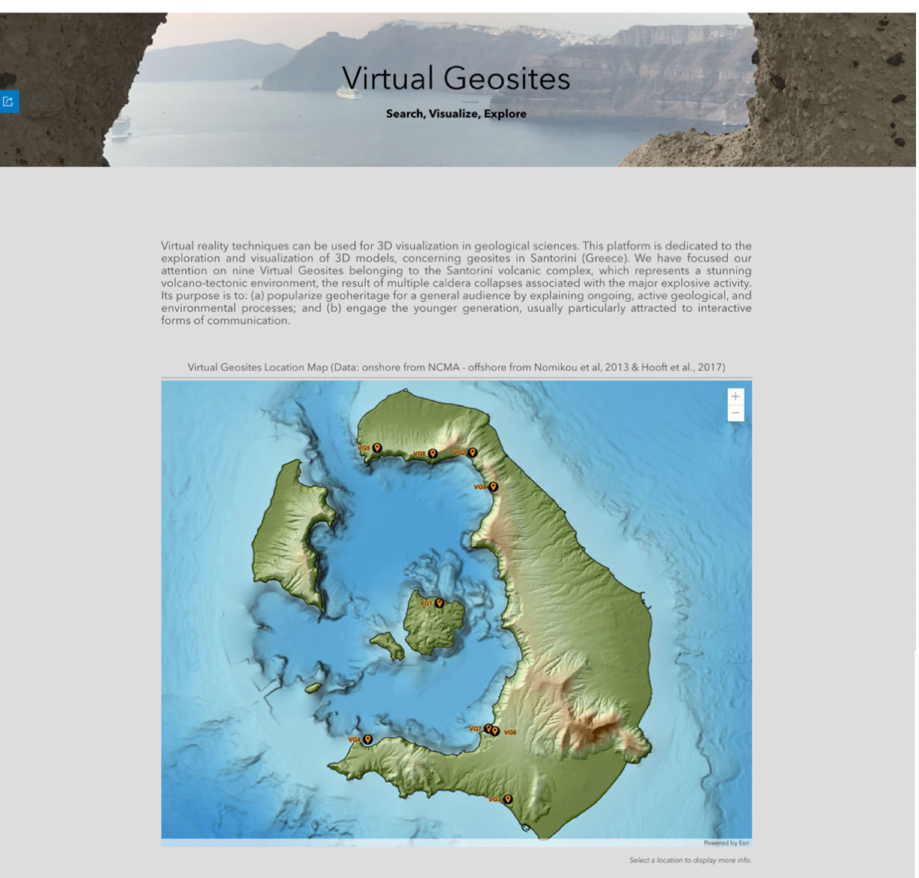
Figure 2. Screenshot showing part of the hub created for Santorini’s virtual geosites. An interactive 2D morphological webmap outlines the location of the VGs. The users can select a location to obtain more